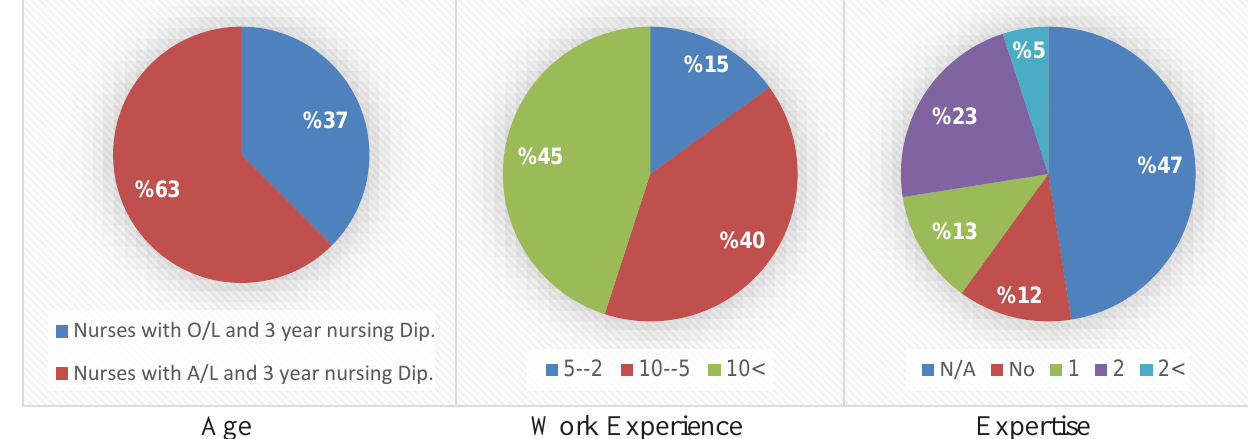
Fig. 3. Personal characteristics of the